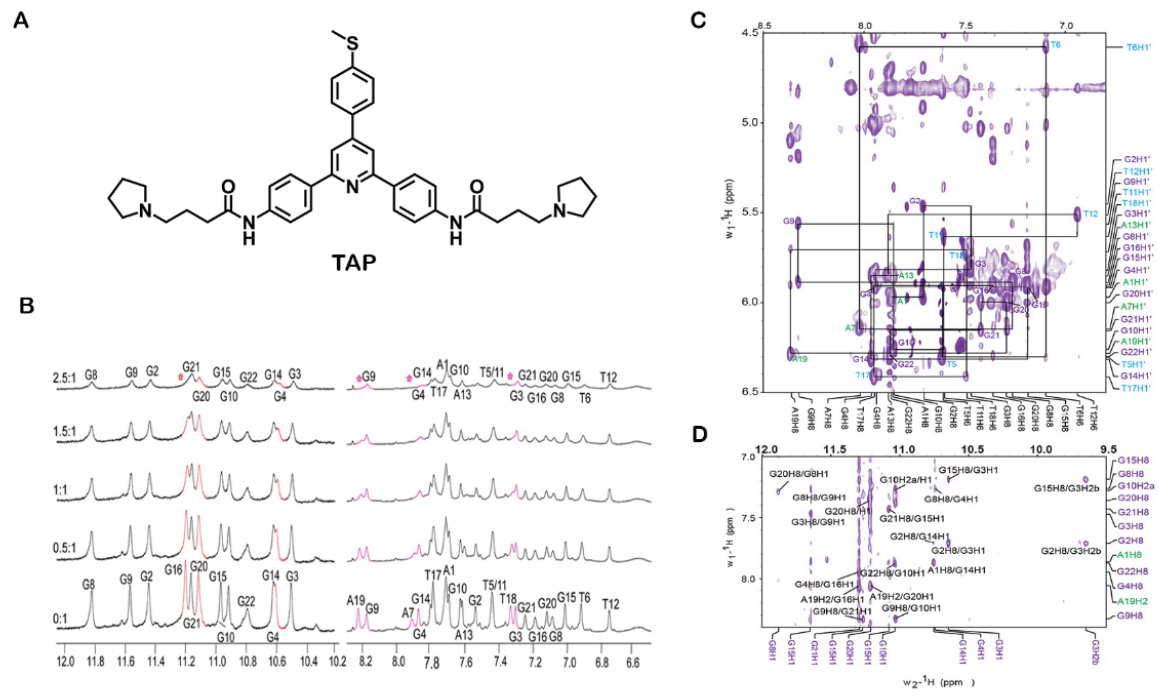
Figure 12. ( A ) Chemical structure of 2,4,6-triarylpyridine (TAP). ( B ) Imino and aromatic proton regions titration spectra of 500 μ M 22AG with different concentrations of TAP in 200 μ L of sodium phosphate buffer containing 20 mM Na 2 HPO 4 /NaH 2 PO 4 , 70 mM NaCl at pH 6.9. ( C ) Expanded H8/H6-H1 ′ 300 ms 2D–NOESY spectrum of the 2.5:1 TAP:22AG complex. ( D ) Expanded H1-H8/H2 region from a 300 ms 2D–NOESY spectrum of the TAP:22AG complex at 2.5:1 stoichiometry. Reprinted with permission from ref. [150] Copyright 2017 Elsevier.